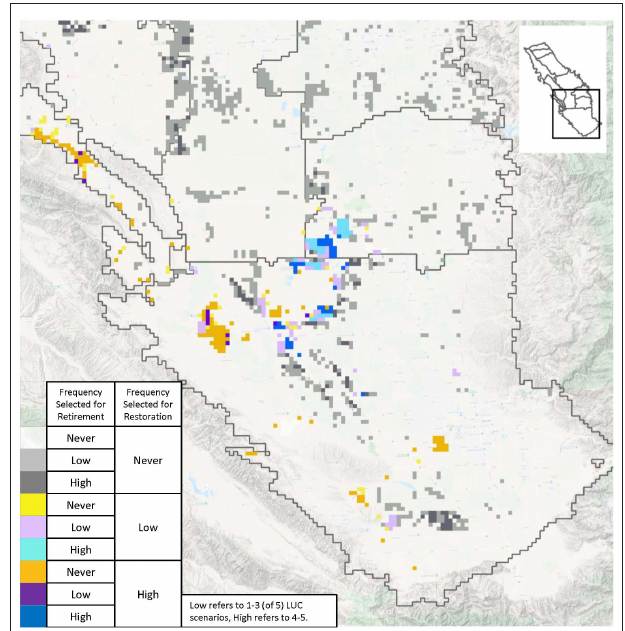
FIGURE 6 | Areas selected for restoration in order to create 10,117 ha (25,000 acres) of new high quality habitat for each of five focal species while minimizing additional cost to the agricultural economy. Colors simultaneously reflect the relative frequency with which lands were selected to be a part of the habitat solution, as well as the frequency lands were identified as likely to be retired. Together these provide an indication of where retirement and restoration are well-aligned (blue colors), and where shifting production may be useful to enhance restoration while preserving production. Modesto (R1), Turlock (R2), Merced-Chowchilla-Madera